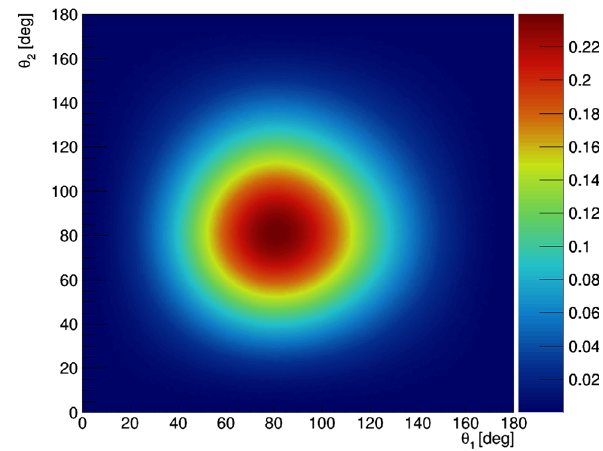
Fig. 10 Visibility V 2 as a function of the scattering angles θ 1 and θ